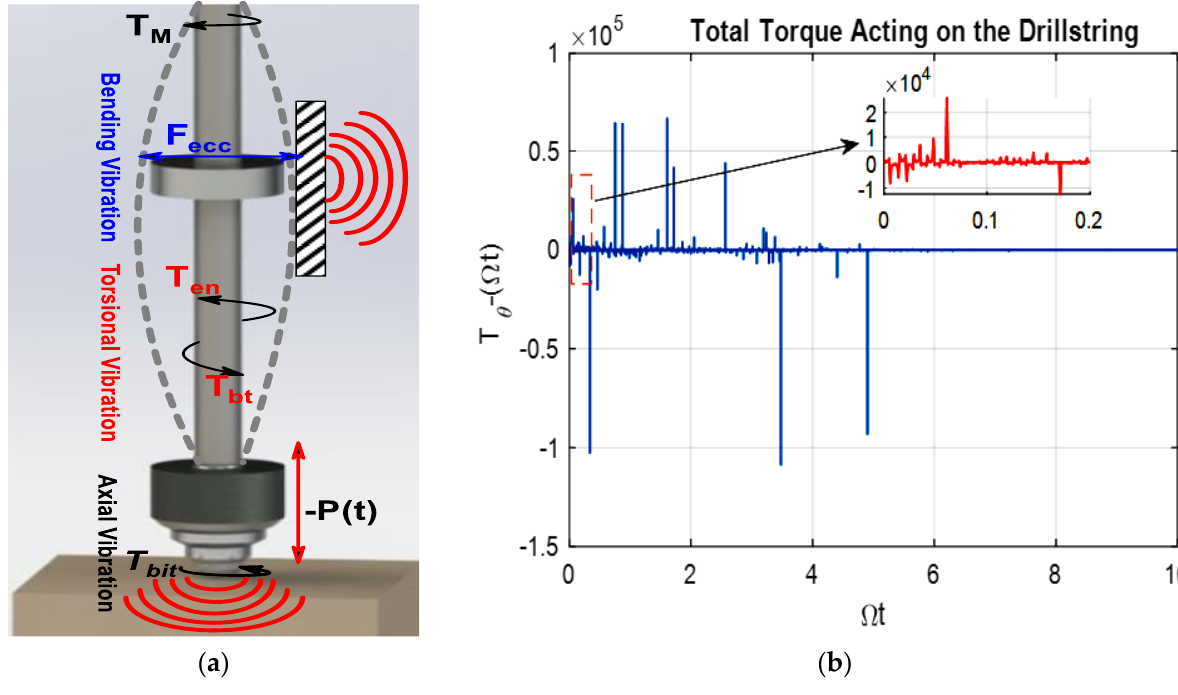
Figure 3. Schematic diagram of a bit–rock interaction during full operation and the full torque profile. ( a ) Full bit-rock torque contact. ( b ) Full bit-rock torque plot in drilling rig work.